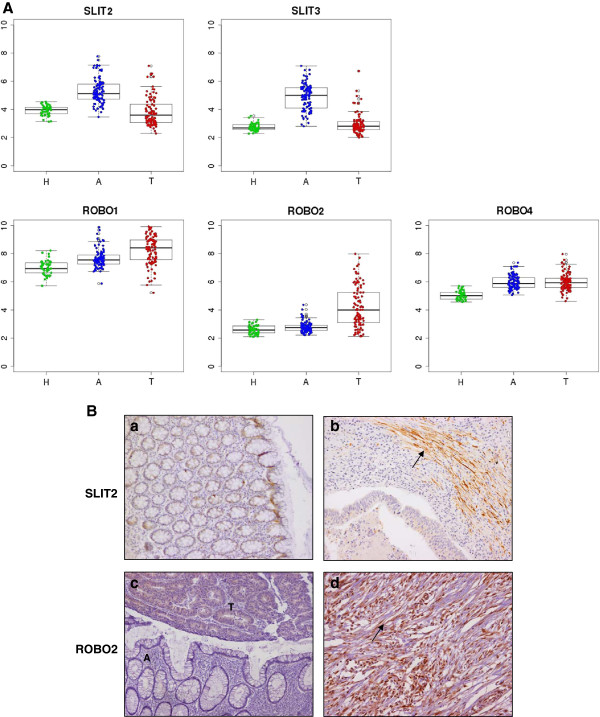
Slit2 and Robo2 expression. A. Microarray gene expression for Slit and Robo family of genes. Tumor samples (T) are colored in red, adjacent samples (A) in blue and healthy mucosa (H) in green. B. Immunohystochemical staining of Slit2 corresponding to normal epithelial cells from an adjacent mucosa from a cancer-affected patient (a). However, Slit2 antibody stained basically carcinoma-associated fibroblasts and was nearly absent in tumor cells (b). For Robo2, the staining clearly shows how this protein is restricted to tumor tissue, and depending on the patient staining only tumor cells (c) or both tumor cells and carcinoma-associated fibroblasts (d). In staining c, tumor and adjacent tissue are marked as T and A. Carcinoma-associated fibroblast are marked with an arrow in b and d photographs.